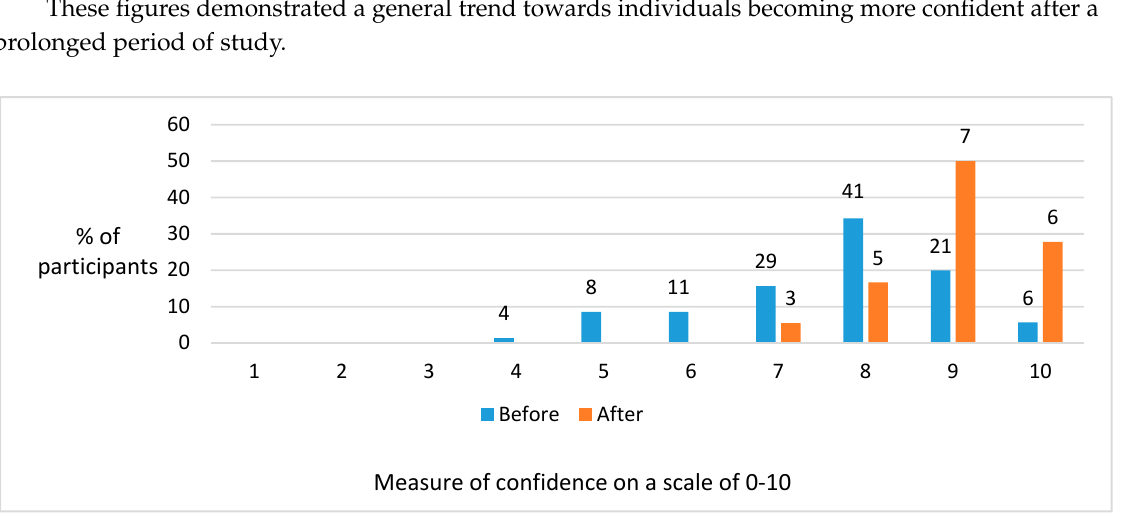
Figure 1. Changes in confidence levels (where 0 = no confidence and 10 = total confidence) with respect to communication skills before and after the programme. The numbers above the columns are actual numbers of participants.